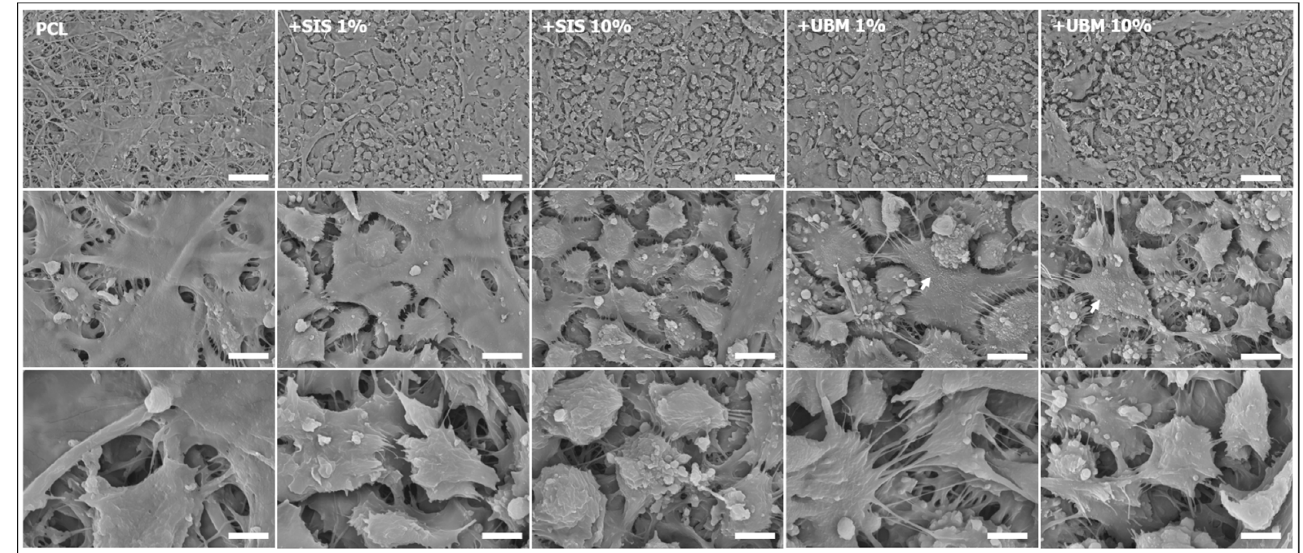
Figure 7. Representative scanning electron microscopy images of human conjunctival epithelial cells cultured on electrospun scaffolds fabricated from poly( ε -caprolactone) (PCL) and PCL with addition of 1% or 10% decellularised tissue powder (small intestinal submucosa (SIS) and urinary bladder matrix (UBM)). Images: top row = ×1000 (scale = 50 µm), middle row = ×5000 (scale = 10 µm), bottom row = ×10,000 (scale = 5 µm); arrows indicate presence of microvilli.